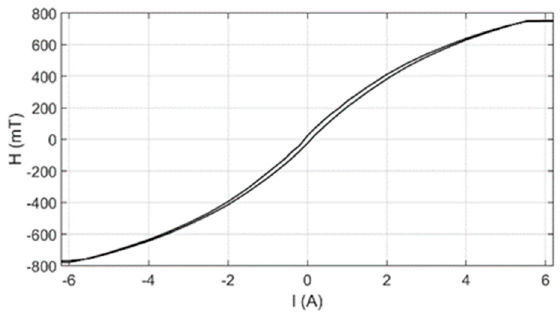
Figure 12. Magnetic field intensity vs. current intensity.